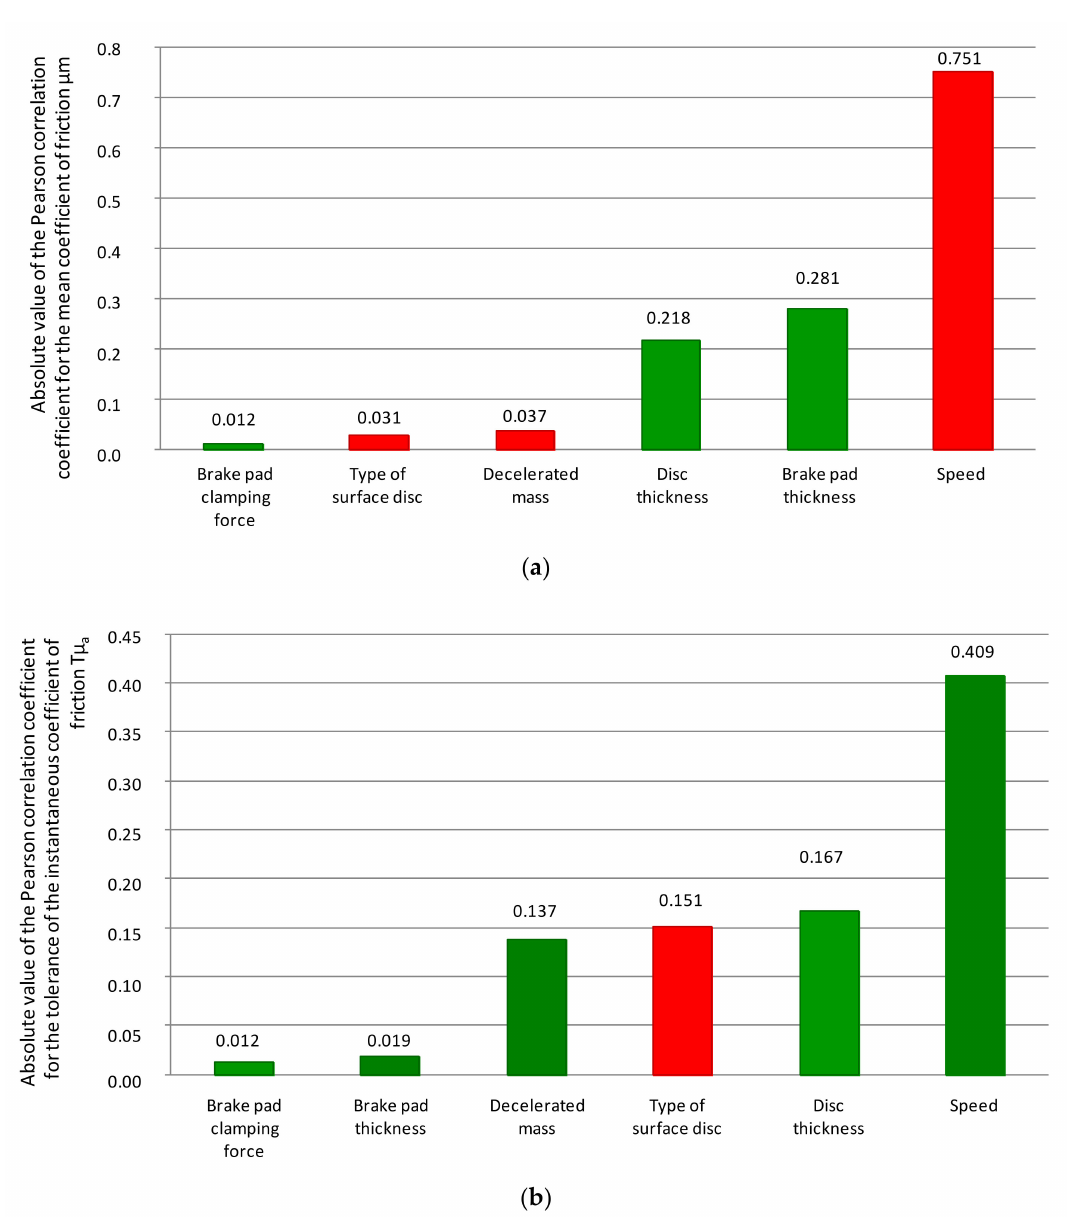
Figure 10. Distribution of the absolute value of the Pearson correlation coefficient for the variables of the regression model; ( a ) coefficient of friction and ( b ) tolerance (changes in the instantaneous coefficient of friction); red indicates an increase in the variable that caused a decrease in the value of µ m or T µ a ; green indicates an increase in µ m or T µ a with an increase in the value of the